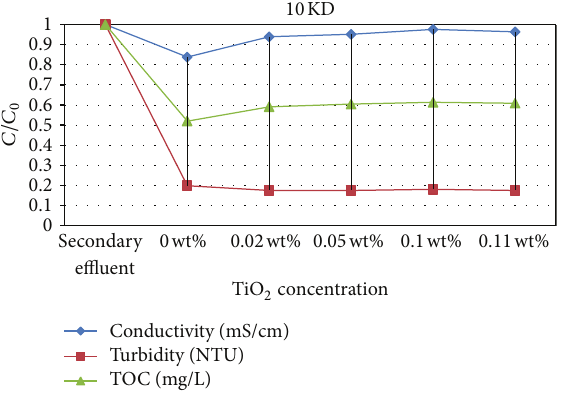
Figure 13: Permeate quality when treated with different TiO 2 concentrations